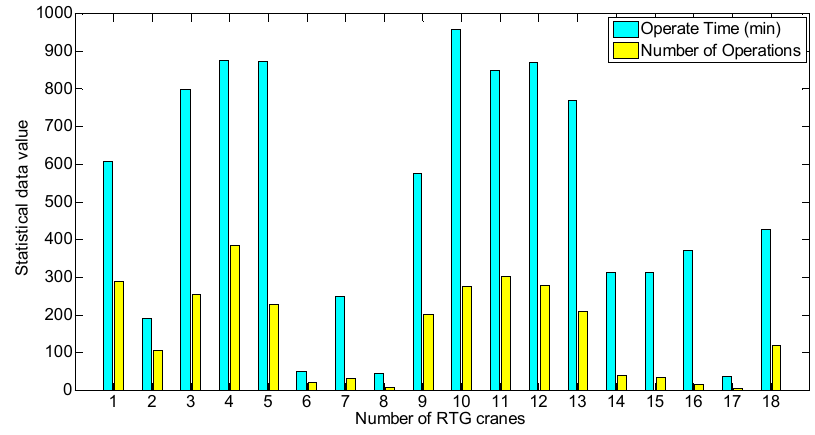
Figure 6. The statistics of RTG cranes.